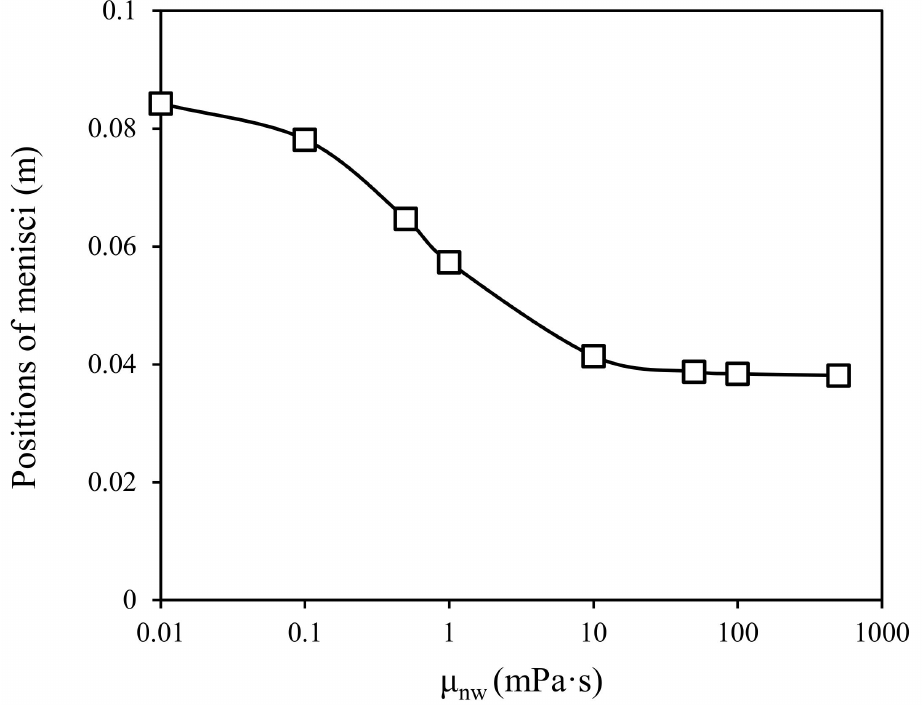
Figure 11. The positions of menisci of different wetting phase viscosities of three interacting capillaries. In order to analyze the effect of viscosity ratio on imbibition, different viscosity ratio schemes of 0.1, 1, and 10 are designed, respectively. The imbibition results are shown in Figure 13. When the viscosity ratio is constant, the oil amount of imbibition is a certain value, which has nothing to do with the wetting or non-wetting viscosity. The viscosity only affects the rate of imbibition. When the viscosity ratio is small, the amount of